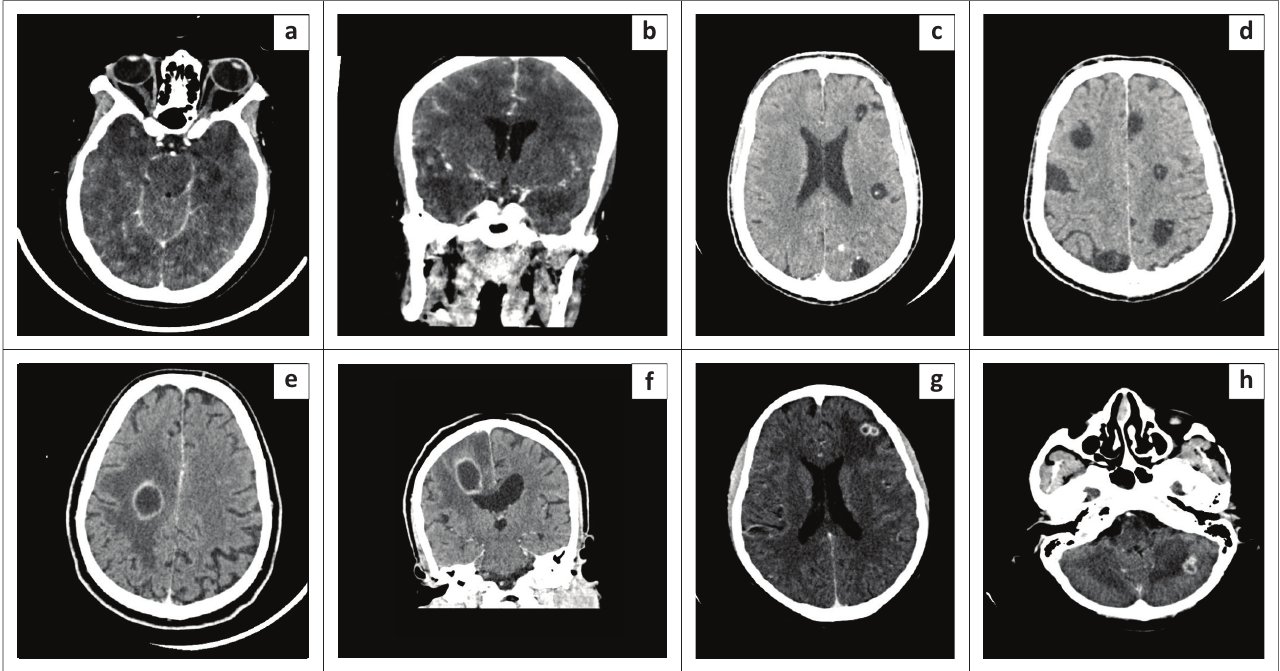
FIGURE 2 : Infective pathology as a cause of adult-onset seizures. (a and b) Herpes Simplex (HSV) encephalitis in a young immunocompromised female patient. Axial NECT: Bilateral anterior temporal lobe oedema with hyperdense foci in keeping with microhaemorrhages. (c and d) Neurocysticercosis in a 47-year-old male with newly diagnosed HIV. Axial - contrast enhanced CT (CECT): Multiple bilateral non-enhancing round CSF density cystic intra-axial lesions of varying sizes with central hyperdense scolices (dot sign). (e and f) HIV positive patient on tuberculosis treatment. Coronal and axial CECT: Large right frontal lobe ring-enhancing lesion adjacent to the right lateral ventricle. Surrounding vasogenic oedema with associated mass effect. A differential diagnosis of a pyogenic or a tuberculous abscess was given. (g and h) A 53-year-old HIV positive male patient. CD4 = 26 cells/µL. Axial CECT: Multiple ring-enhancing lesions with vasogenic oedema in the cerebellum and corticomedullary junction of cerebrum. A differential of toxoplasmosis and tuberculomas was